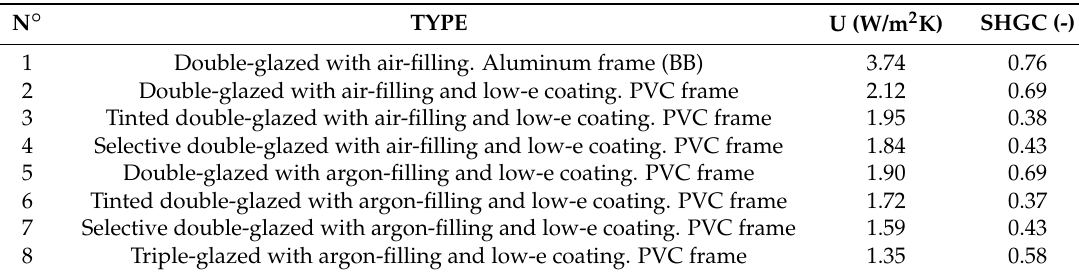
Table 7. Investigated window types.